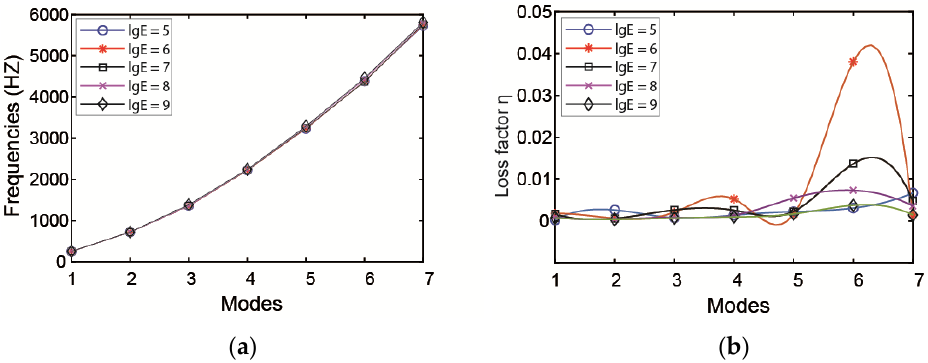
Figure 4. Influence of elasticity modulus of viscoelastic layer on ( a ) modal frequency and ( b ) loss factor.